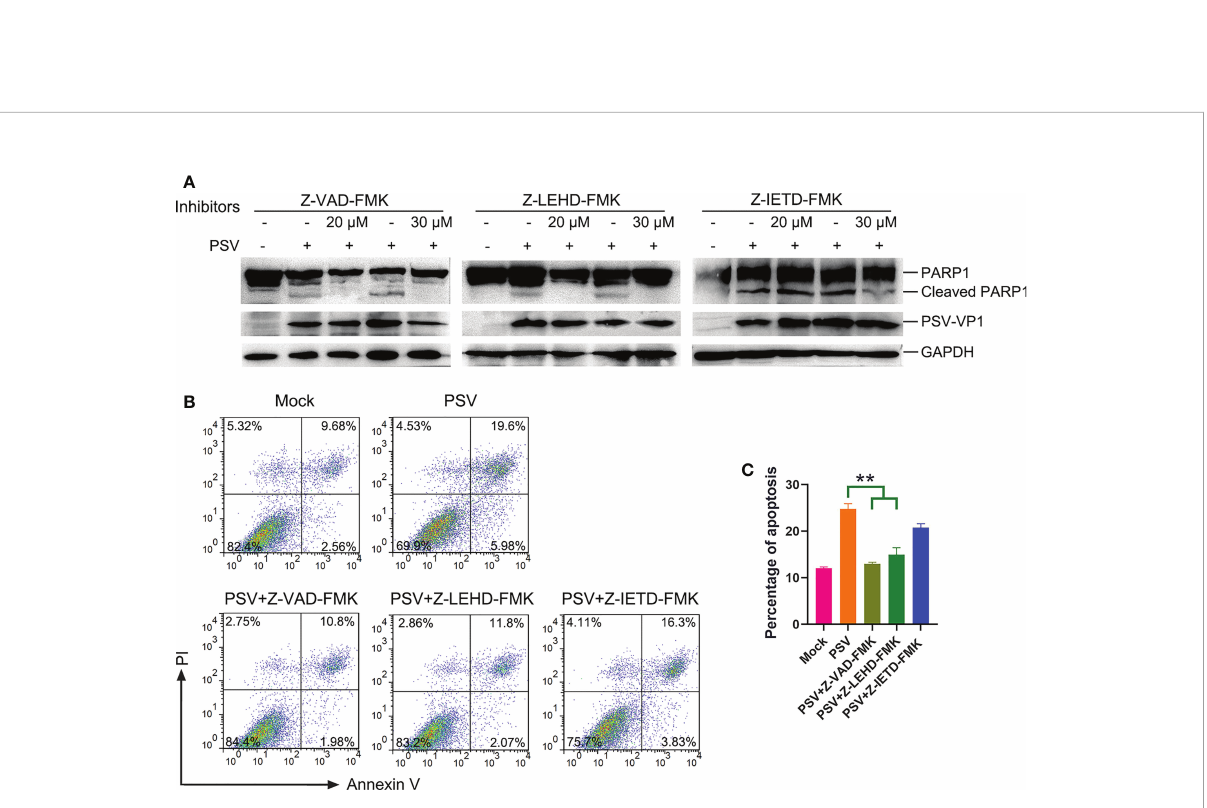
FIGURE 3 Caspase inhibitors affect PSV-induced apoptosis. (A) ST cells were pretreated with caspase inhibitors (Z-VAD-FMK, Z-LEHD-FMK, and Z-IEHD- FMK) (20 or 30 m M) and infected with PSV. After 24 h, the cellular lysates were detected by Western blot using antibodies against PSV-VP1 and PARP1. (B, C) ST cells were pretreated with caspase inhibitors at 30 m M, followed by PSV infection. Cells were harvested at 24 hpi, stained with Annexin V and PI, and then examined through fl ow cytometry. The graph represented the percentage of Annexin V positive quadrants (n = 3). **P <